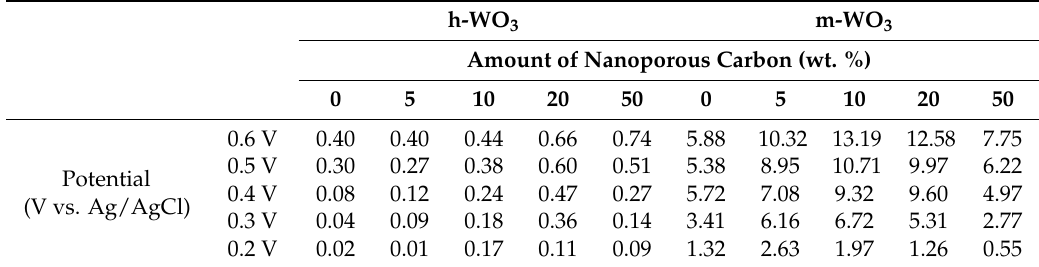
Table 1. IPCE values of all studied electrodes at applied potentials between 0.6 and 0.2 V vs.